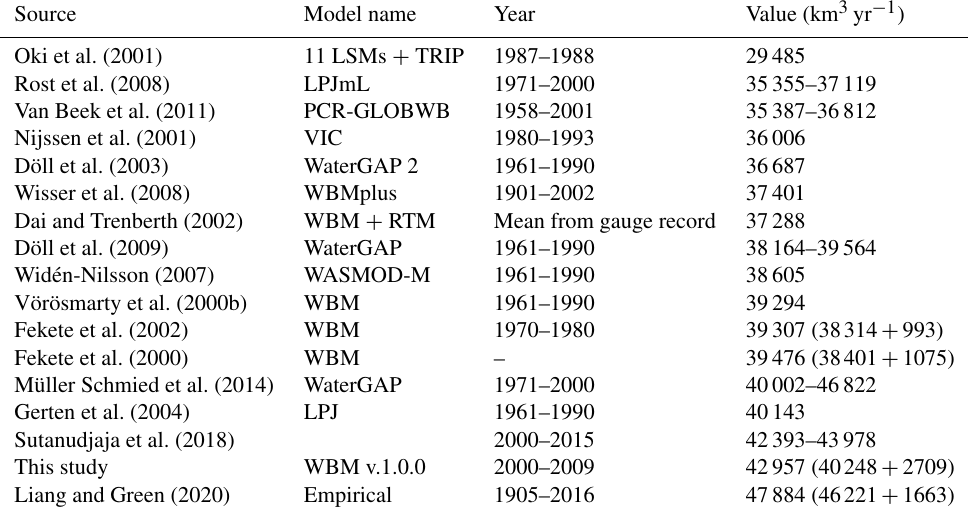
Table 5. Model estimates of global river discharge, ordered from lowest (based on the low end of a range, for models that report ranges) to highest. Parentheses show the exorheic + endorheic discharge for studies that provide a separation of external and internal basin